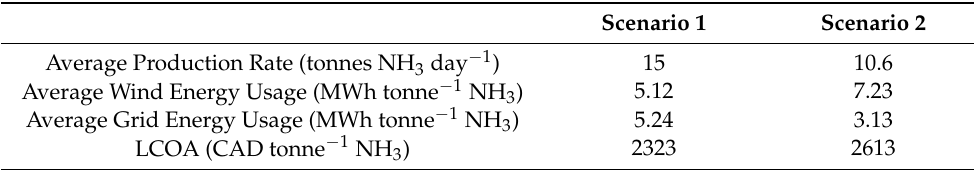
Table 6. Production and power comparison for the two scenarios.